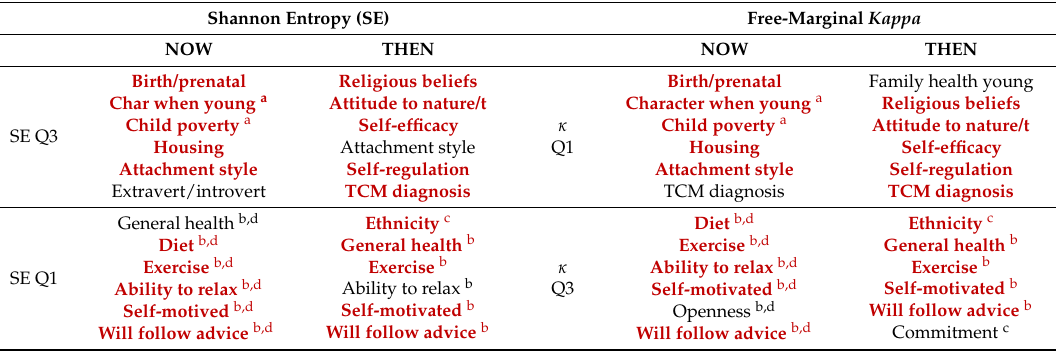
Table A21. Survey questions in the upper and lower deciles for SE and kappa scores. As in Table 3, items shown in bold red type appear in the same deciles both NOW and THEN.